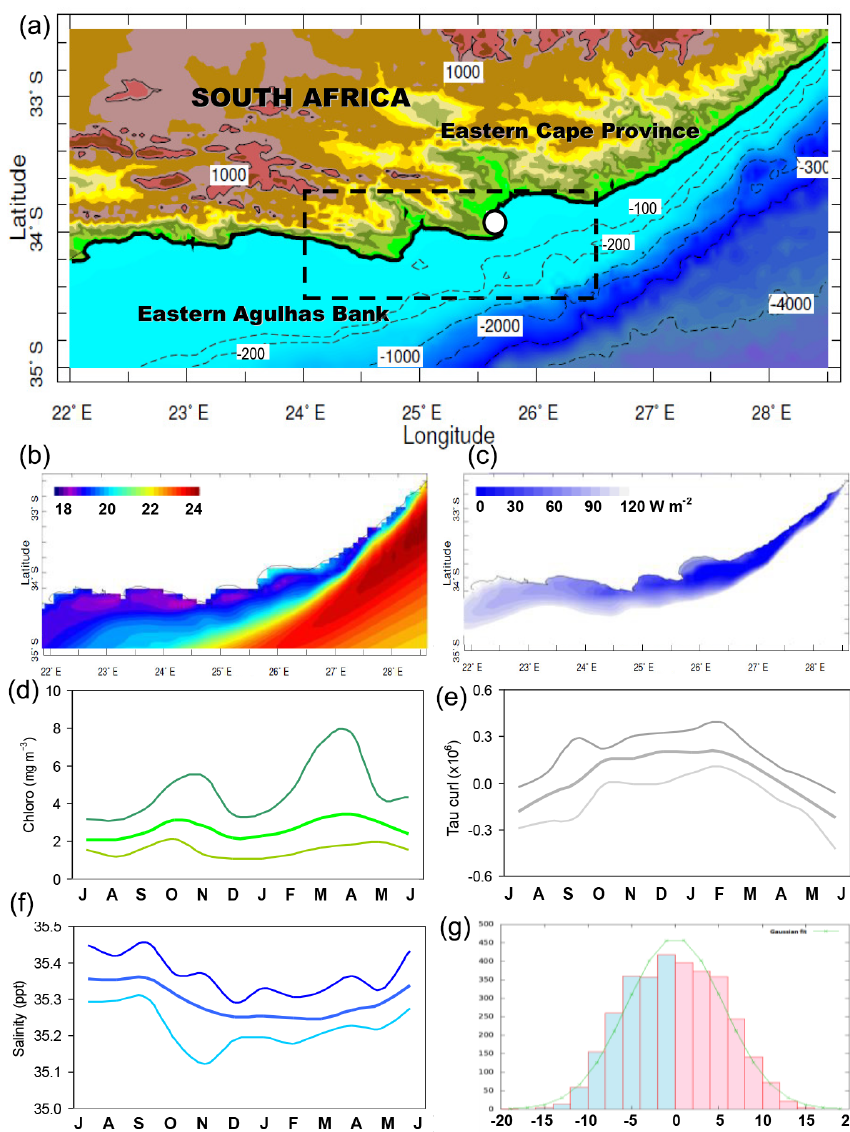
Figure 1. (a) Topography of the outer study domain (and dashed index area), shelf bathymetry, and Port Elizabeth (dot). Mean maps, 2006– 2017, of HYCOM reanalysis (b) SST ( ◦ C) and (c) net heat flux (shaded <120Wm − 2 ). Index-area mean annual cycle of (d) chlorophyll fluorescence, (e) wind stress curl, and (f) salinity, with upper and lower 2.5 percentiles; summer is unified. (g) Histogram of index-area daily zonal wind, (blue is from east and red is from